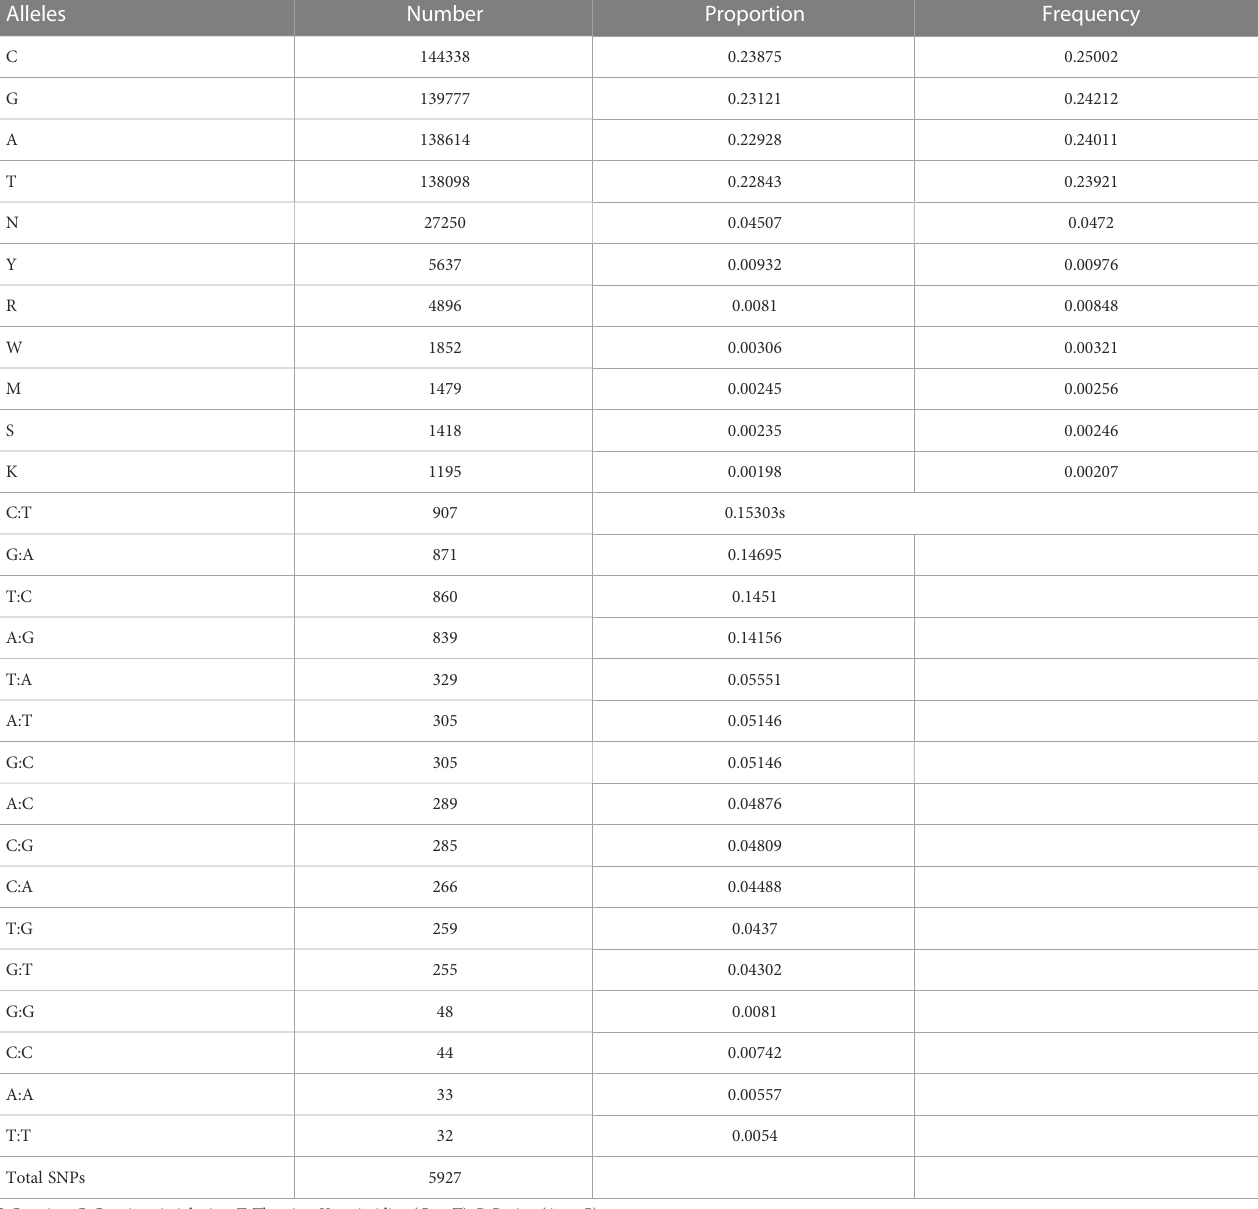
TABLE 3 Summary of genomic sequencing.